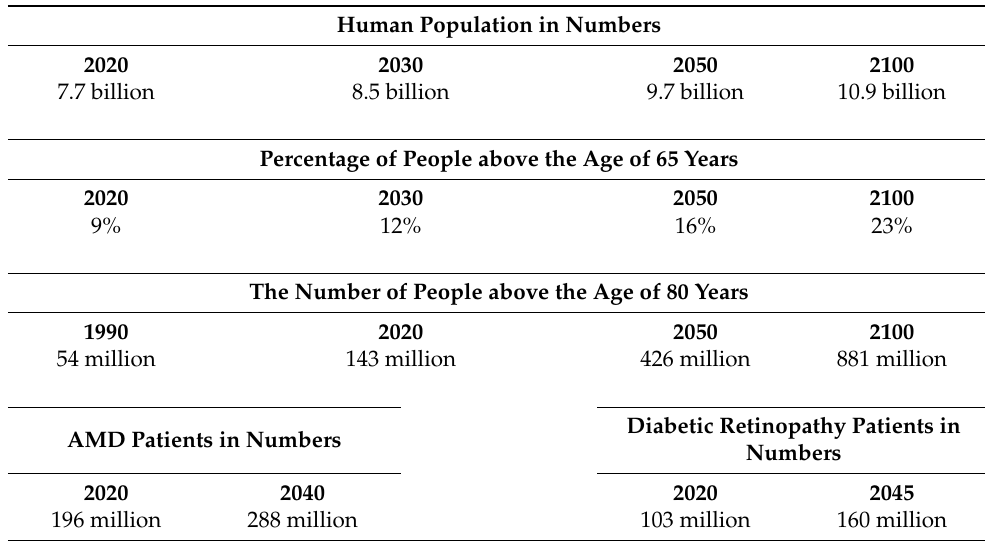
Table 1. Global assessments of human population and major retinal disease. Data adapted from the following: